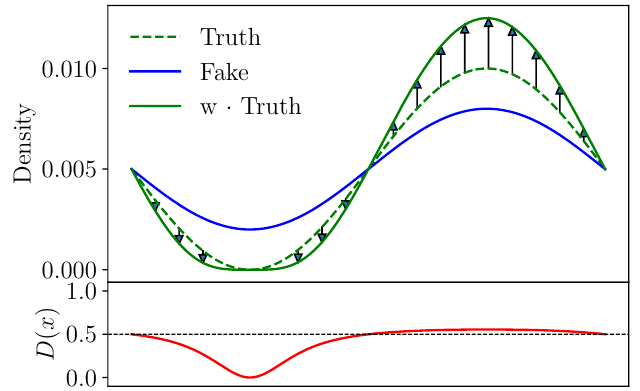
Figure 6: Illustration of the DiscFlow method. Weights computed by the discrimi- nator shift the reference (true) density downwards whenever the generator (fake) distribution overshoots and vice-versa. This way the deviations of the to-be-trained generator density are